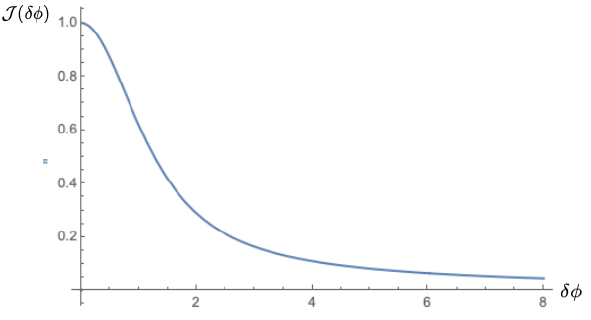
Figure 4 . The Janus correction function. Observe that for vanishing dilaton variation the mass is not